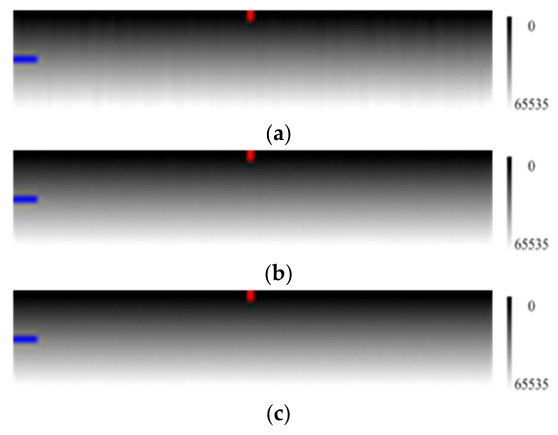
Figure 6. The relative calibration results of the verification image with the horizontal direction for the pixels and the vertical direction for the radiance level. ( a ) the result with the calibration coefficient from Figure 3a; ( b ) the result with the calibration coefficient from Figure 3b; and ( c ) the result with the calibration coefficient from Figure 3c. Column 50 and line 10 are marked with red and blue labels, respectively.